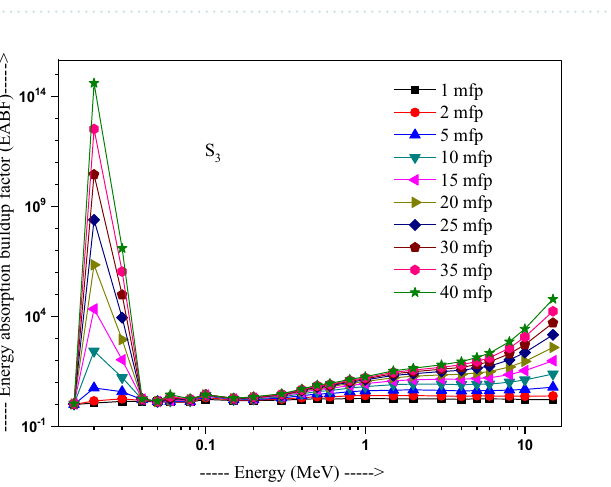
Figure 15. Variation of energy absorption buildup factor with energy for 20Bi 2 O 3 − xPbO − (80 − 2x) B 2 O 3 − xGeO 2 (x = 10) glass (S 2 ).